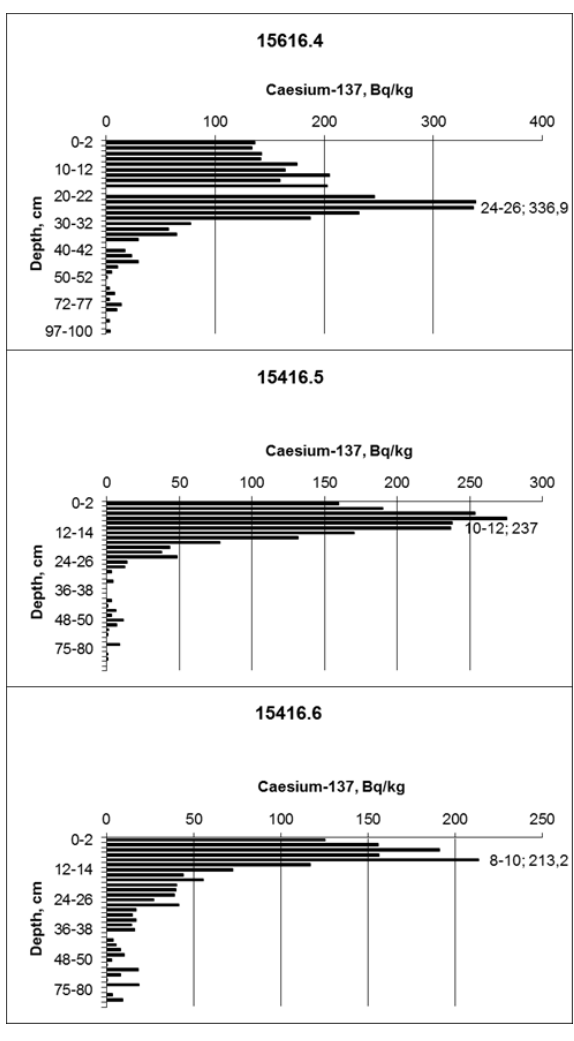
Figure 4 . Plots of caesium-137 specific radioactivity observed on depth of the soil layer at sampling points 4 (plot 15616.4), 5 (plot 15416.5), and 6 (plot